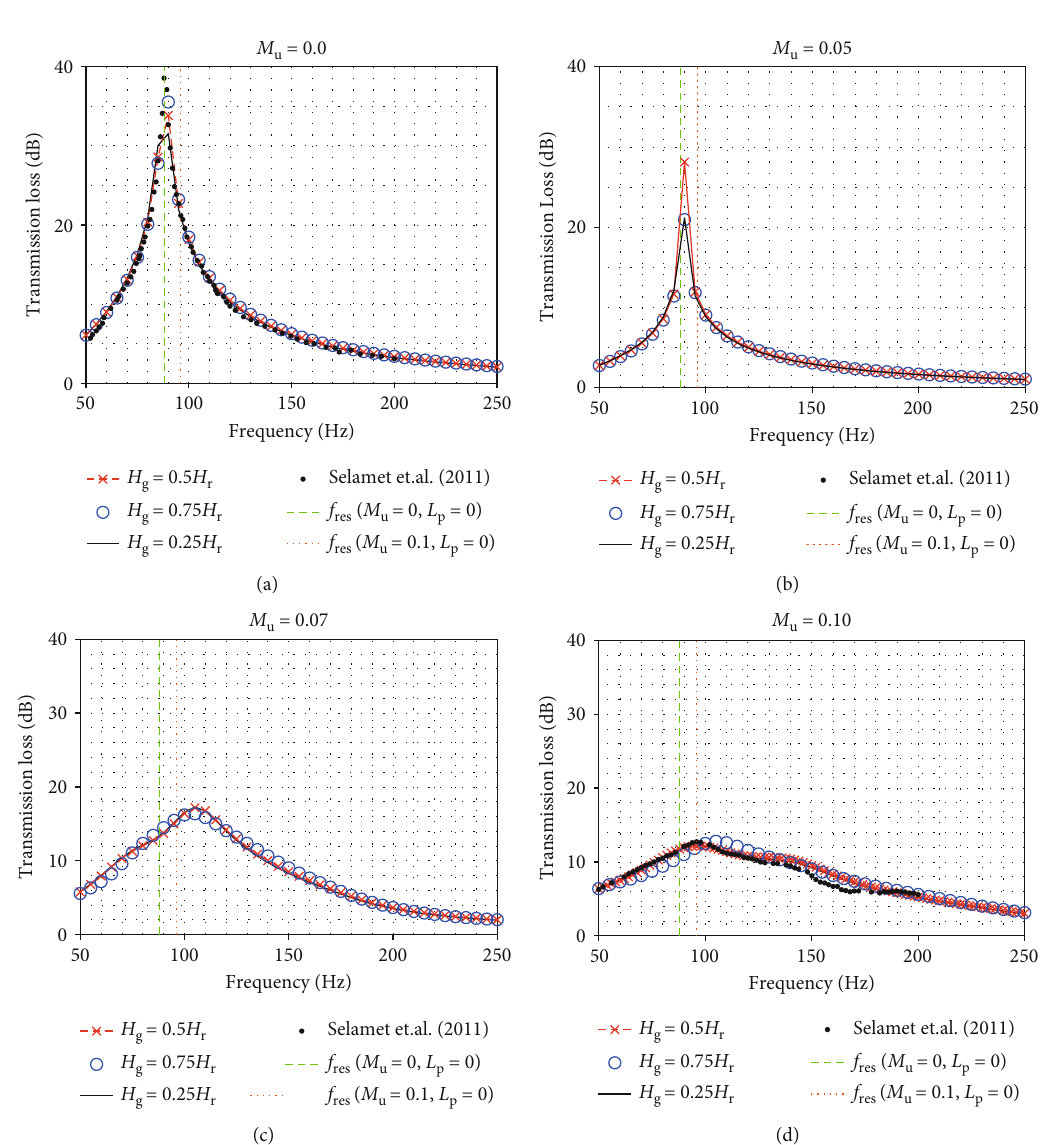
= 0 : 5 D and the rigid ba ffl e is attached at 3 di ff erent locations, i.e., p r = 0 : 05 , (c) M = 0 : 07 , and (d) M u u